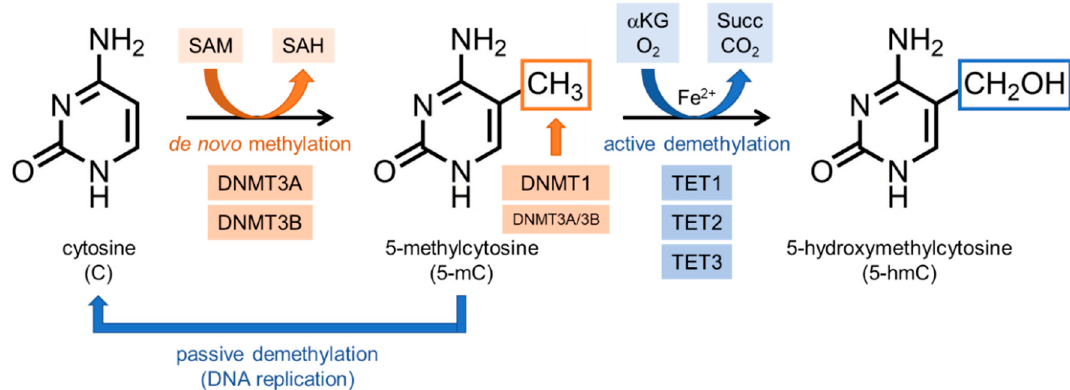
Figure 3. Enzyme-mediated DNA methylation and demethylation processes. DNA methylation occurs at the carbon 5 of cytosine in CpG dinucleotides. DNA methyltransferases (DNMTs) catalyze the methylation reaction by transferring a methyl group to cytosine (C) using S-adenosyl methionine (SAM) as methyl donor and producing S-adenosyl homocysteine (SAH). As a product, 5-methylcytosine (5-mC) is generated. DNMTs also maintains the status of DNA methylation. DNA demethylation is a multi-step oxidation process mediated by ten-eleven translocation (TET) methylcytosine dioxygenases (active demethylation). TET enzymes use Fe 2 + and α -ketoglutarate ( α KG) as co-substrates, and generates succinate (Succ) and CO 2 . In the first step of demethylation process, the 5-mC is converted to 5-hydroxymethylcytosine (5-hmC) (shown), and further TET-dependent oxidation leads to the conversion of 5-hmC into 5-formylcytosine (5-fC) and 5-carboxylcytosine (5-caC) (not shown). After several oxidation reactions mediated by TET enzymes, the methyl group is removed by base excision repair mechanism. 5-mC or 5-hmC can also be converted to unmethylated cytosine during DNA replication, through a passive DNA